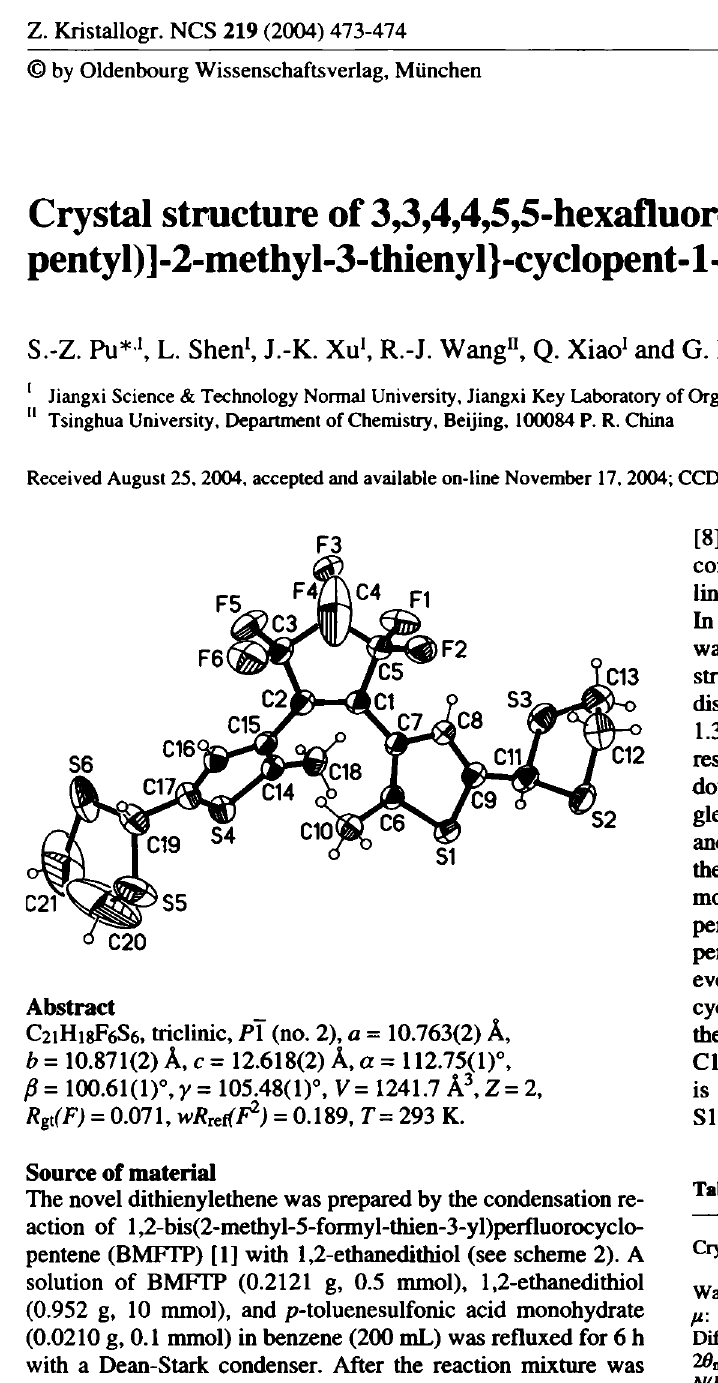
Table 2. Atomic coordinates and displacement parameters (in Â 2